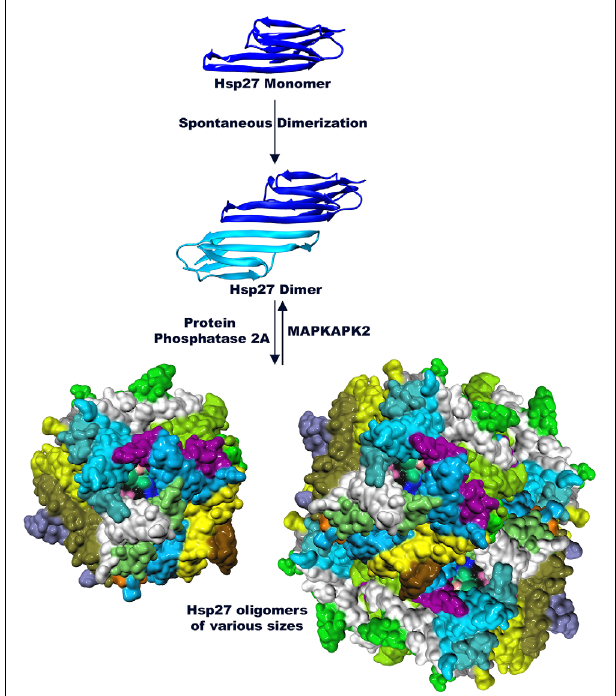
FIGURE 2 | Hsp27 is organized into higher order structures (PDB 6DV5 and 2N3J). The monomer of Hsp27 assembles into dimers via the ACD. Dimers in turn interact with each other to form large highly dynamic multimers. Phosphorylation by MAPKAPK2 dissociates oligomers of Hsp27 and favors dimer formation while Protein Phosphatase 2A shifts the equilibrium towards multimer